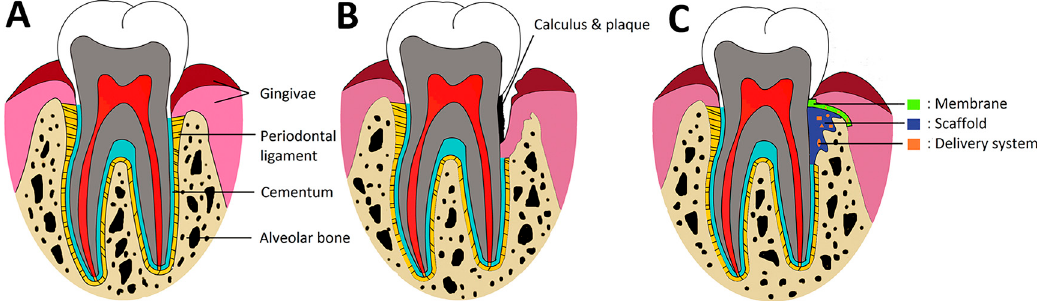
Figure 1. A schematic illustration illustrating the normal periodontal tissues ( A ); injured periodontium in periodontitis ( B ); and forms of PLGA applied for periodontal regeneration process ( C ). In ( C ), PLGA membranes can inhibit the early down-growth of gingival epithelium and connective tissues, allowing regenerative cells to repopulate the denuded root surface; PLGA based scaffolds can provide initial mechanical support and three-dimensional niches for neo-tissue formation; PLGA based delivery carriers can release the biological factors, and antimicrobial drugs to enhance periodontal